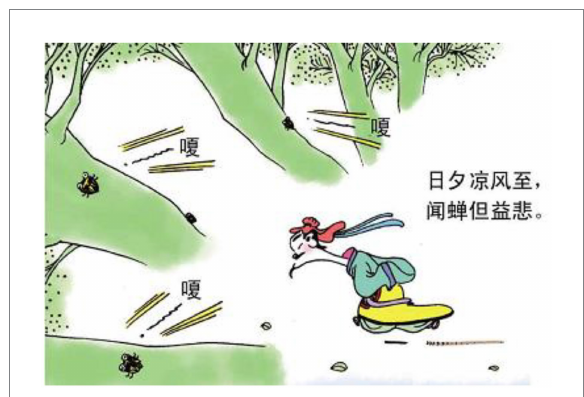
FIGURE 11 The fifth panel on Cai (2014, p. 21). Images reproduced with permission from Shang Dong People Press.